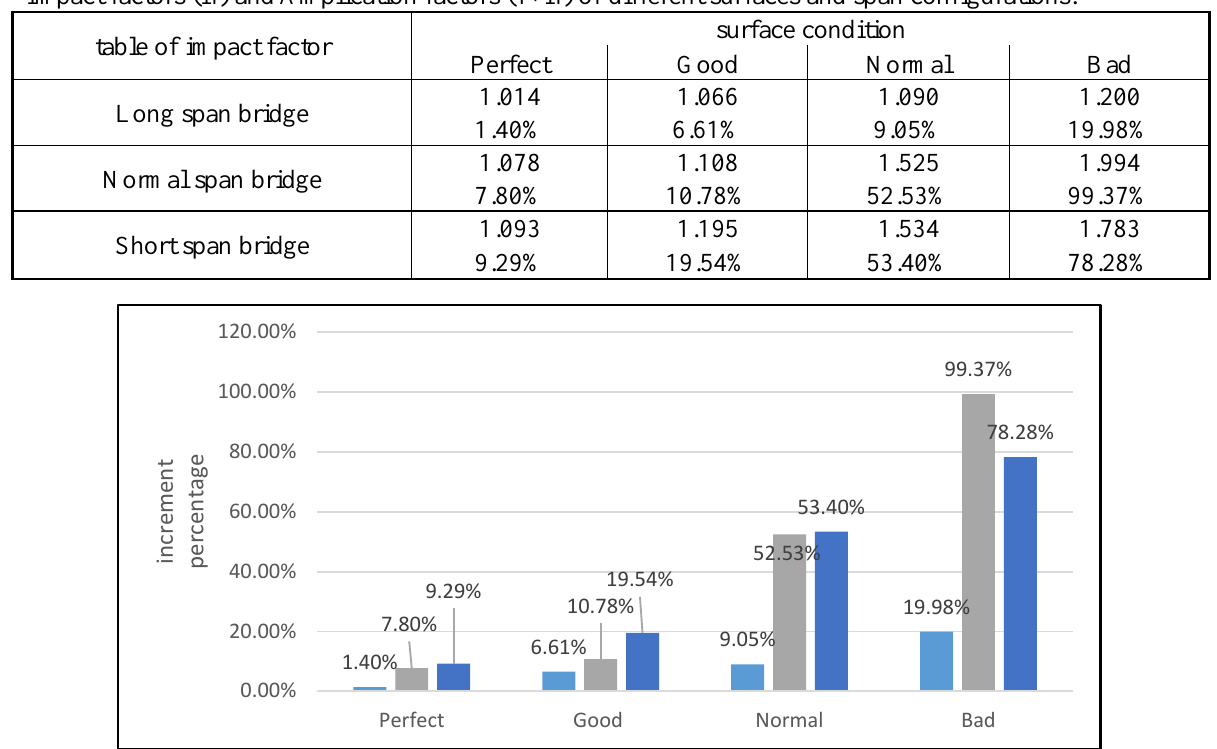
Fig. 11. Impact factor of different surfaces and span configurations.